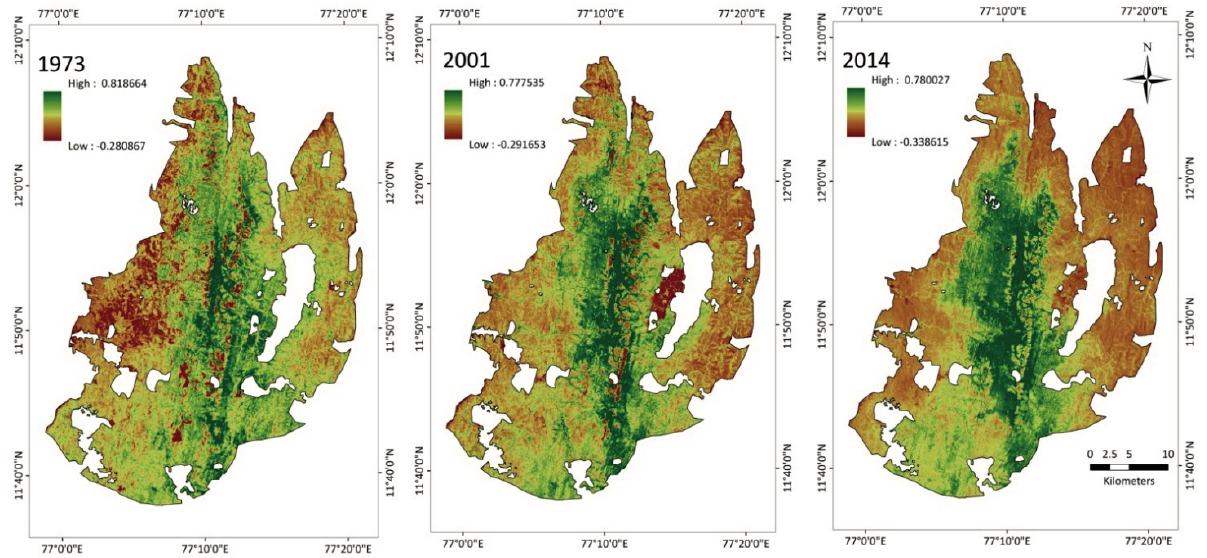
Figure 4. Change analysis shows the NDVI changes in Biligiri Rangaswamy Temple Tiger Reserve (BRT) and adjacent forests from 1973–2001, 2001–2014 and 1973–2014.